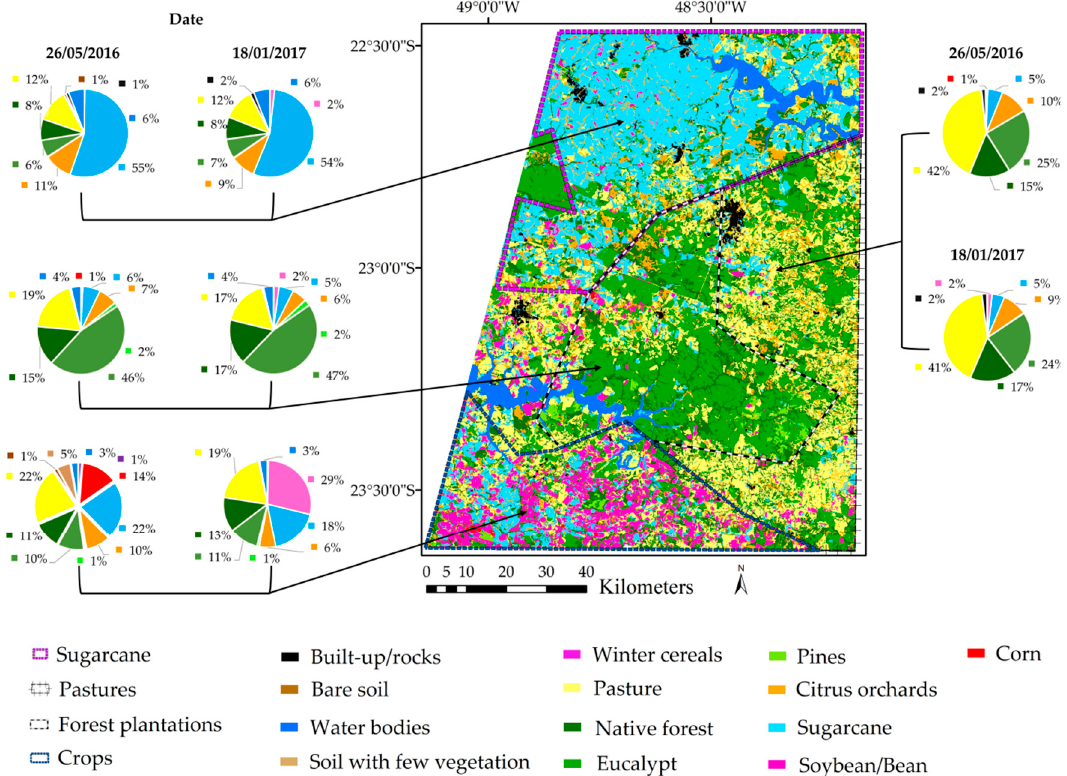
Figure 9. Classification map of the study area obtained for 18 January 2017. Pie charts are the proportion of each land cover on 26 May 2016 ( a ) and in 18 January 2017 for different regions in the study area, which have a majority of annual crops (South), sugarcane (North), pastures (East), or forest plantations